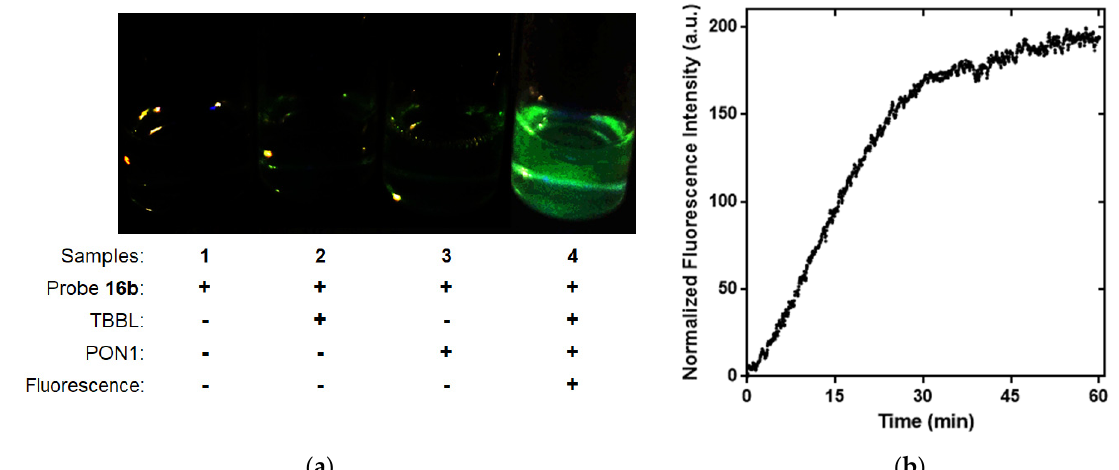
Figure 4. The chemical probe 16b used for accurate determination of PON1 lactonase activity. ( a ) Each vial contained 2 μ M (in dimethyl sulfoxide (DMSO), 0.5%) of 16b in the Tris buffer, and various combinations of PON1 (7.79 U L − 1 , 50% glycerol) and TBBL (5 mM in acetonitrile (ACN), 0.2%). The reactions were carried out at rt for 15 min and visualized and photographed under UV lamp illumination. ( b ) Catalysis of a PON1-TBBL– 16b reaction system was monitored spectrofluorometrically; the reaction contained 16b (0.8 μ M in DMSO, 1.6%), rePON1 (232.1 U L − 1 , 50% glycerol), and TBBL (10 mM in ACN, 1%) in the Tris buffer at 25 °C. The normalized FL intensity at 525 nm was acquired by subtracting a background fluorescence of 16b at the same wavelength from the original fluorescence intensity data.